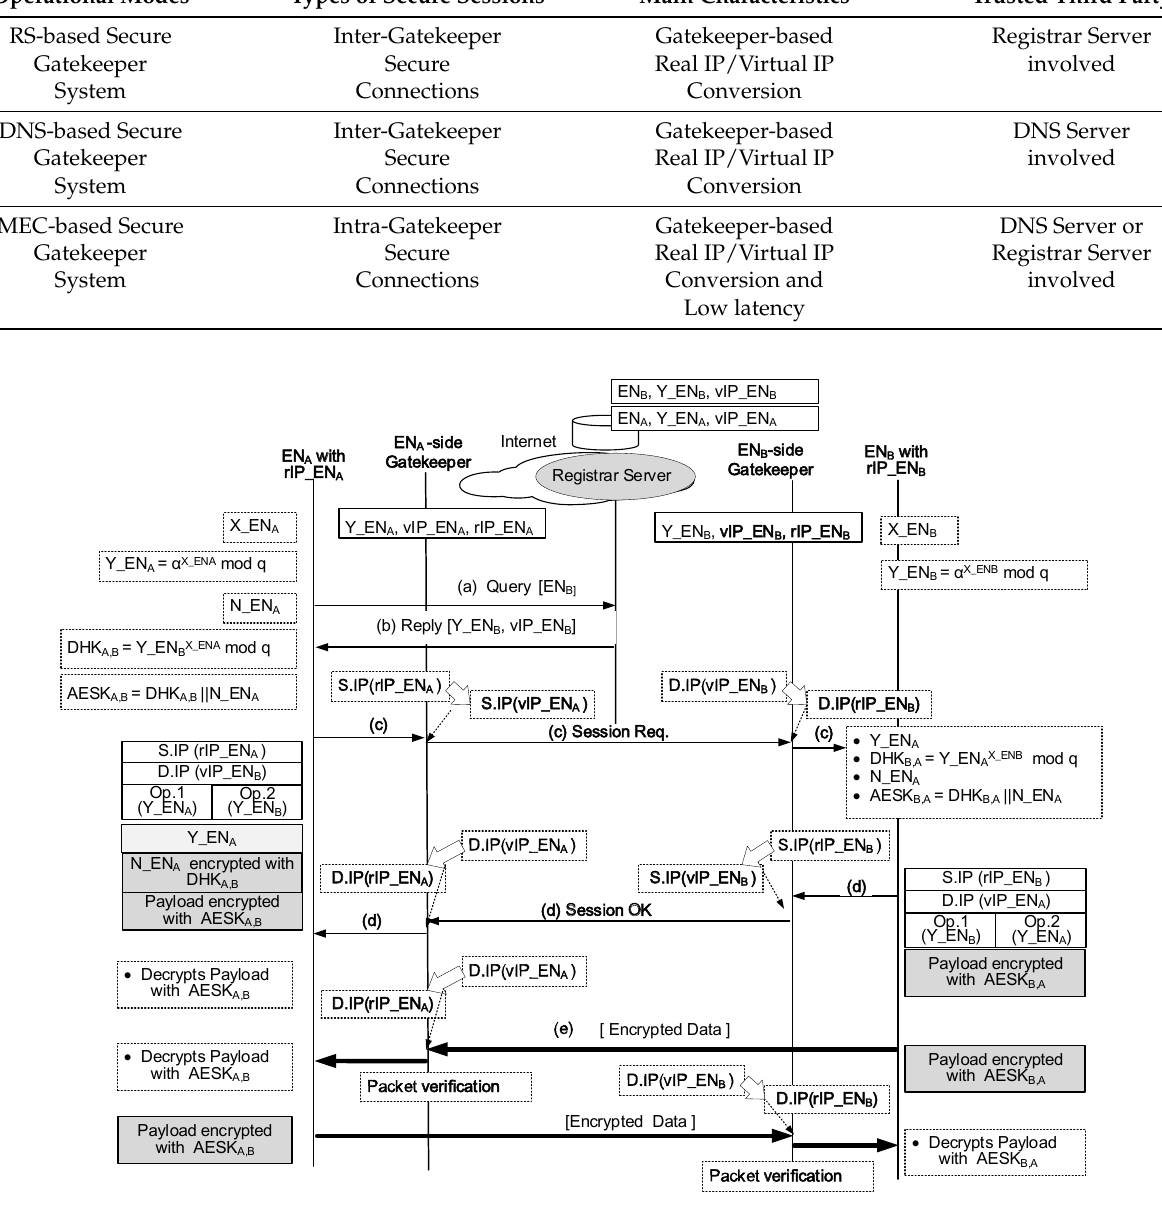
Figure 5. Secure peer-to-peer communication over RS-based Secure Gatekeeper